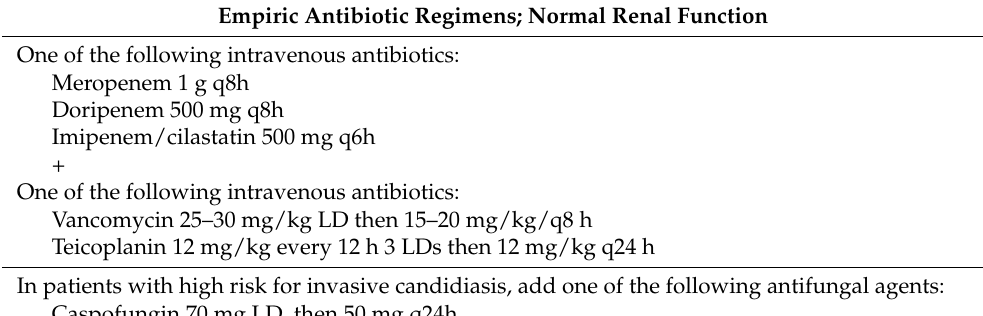
Table 4. Patients with hospital-acquired intra-abdominal infection with sepsis or septic shock. Empiric Antibiotic Regimens; Normal Renal Function